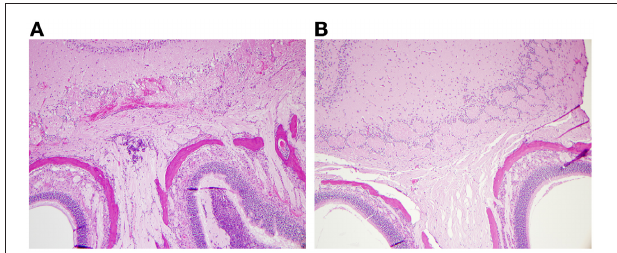
FIGURE 5 | Histopathology of IN infected mice demonstrated damage of the CNS and nasal epithelium. Nasal and olfactory tissue from mice infected by IT or IN inoculation with 10 4 cfu of B. pseudomallei JW280. The heads of (A) IN-infected or (B) IT-infected mice were harvested at 72h, fixed with formalin, embedded, and stained with hematoxylin and eosin. Histological sections were imaged by bright field microscopy.